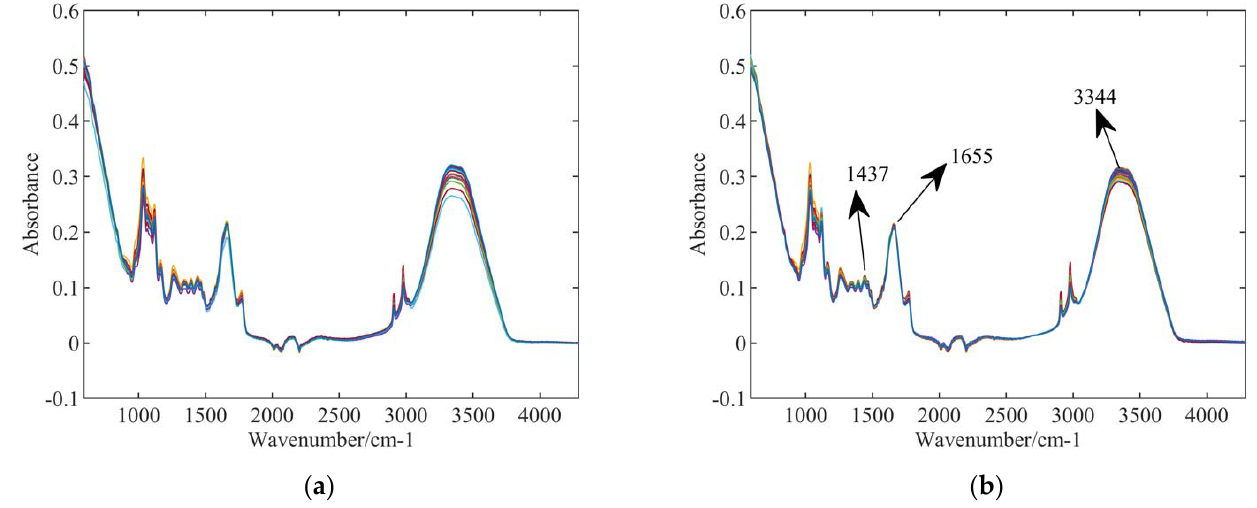
Figure 2. ( a ) Raw spectra of samples with no pesticide; ( b ) MSC processed spectra of samples with no pesticide.